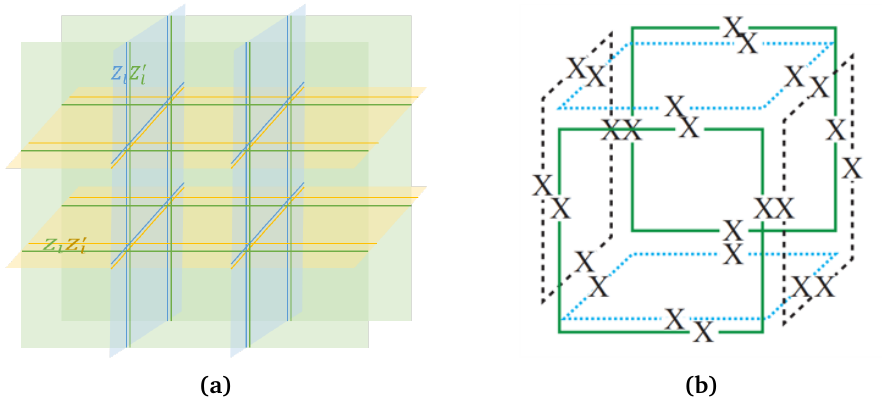
Figure 6: (a) Coupling stacks of toric code layers via a ZZ interaction between over- lapping links; (b) The form of A which comes at sixth order in perturbation c